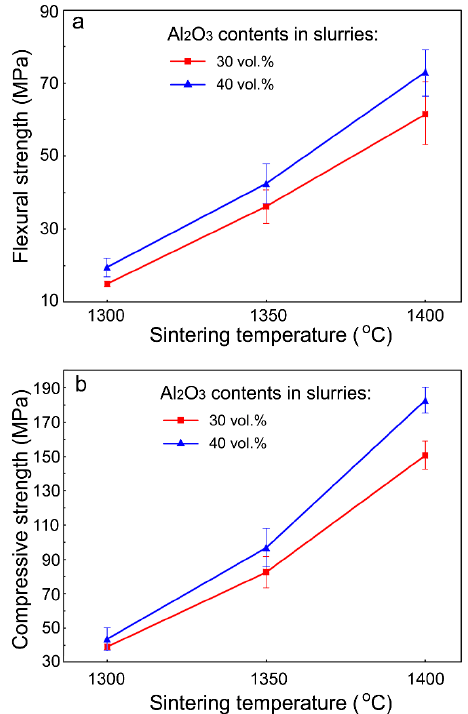
Figure 7. Variation of the flexural strength ( a ) and compressive strength ( b ) of porous Al 2 O 3 ceramics with sintering temperature.